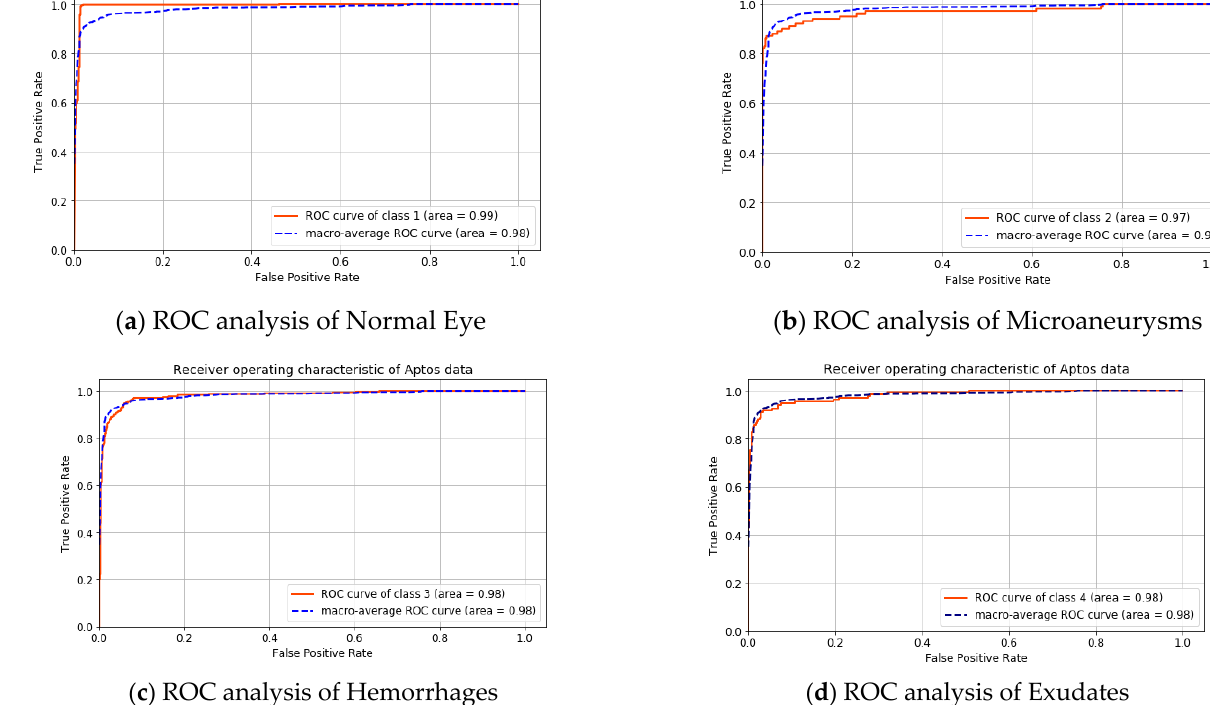
Figure 6. ROC analysis for APTOS dataset.